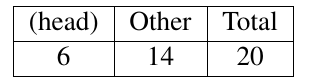
Table 8: Less detailed query C 3 using strong